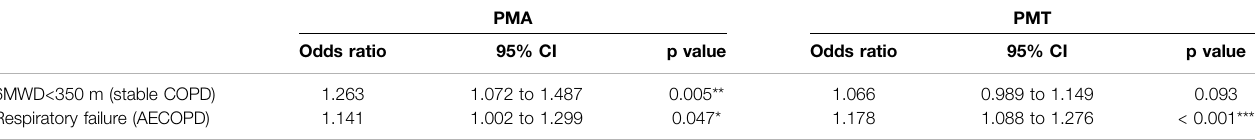
TABLE 7 | Bivariate logistic analyses of the PMA and the PMT for predicting 6MWD < 350 m and respiratory failure. PMA PMT Odds ratio 95% CI p